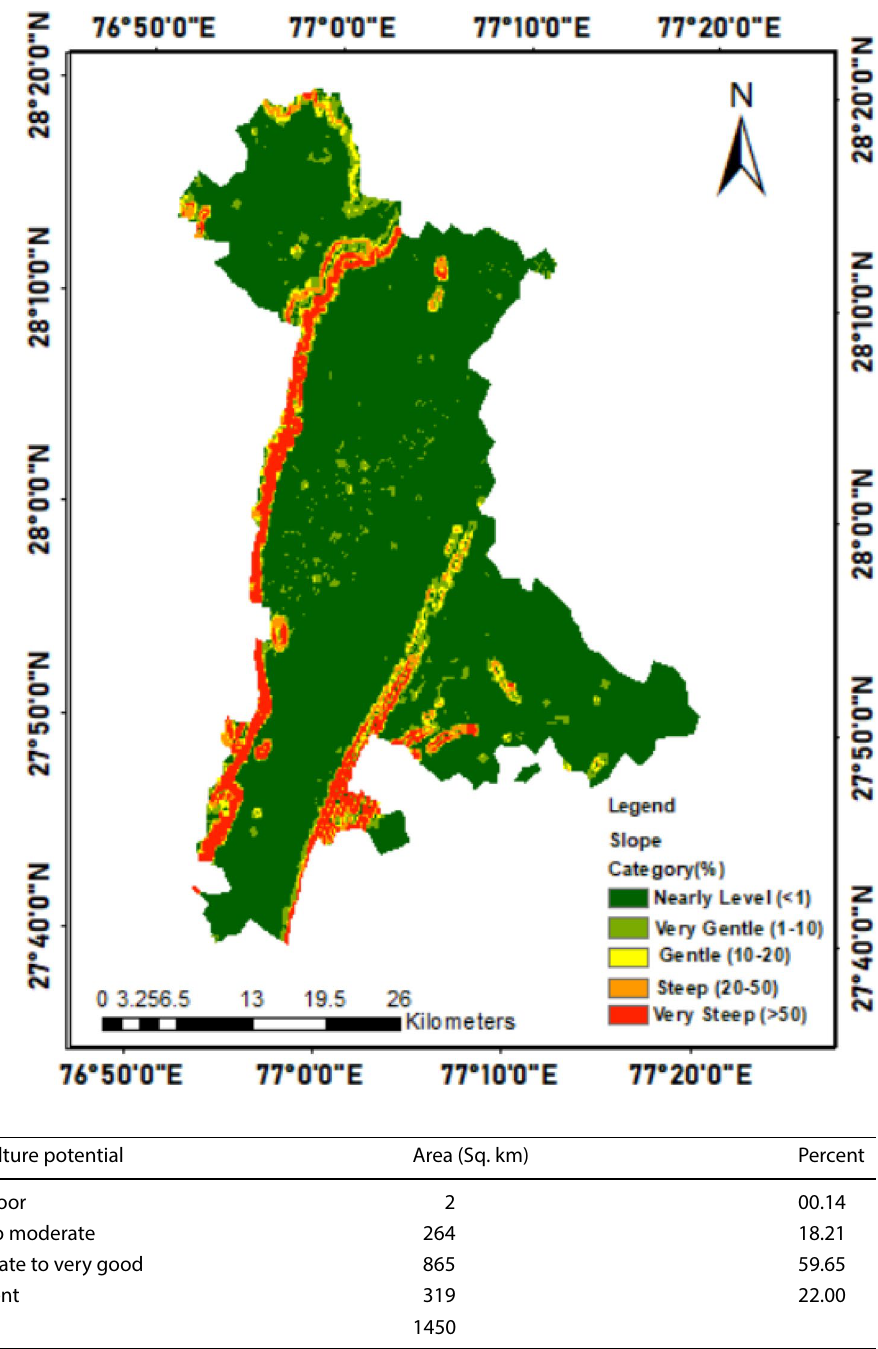
Fig. 15 Slope map of study area